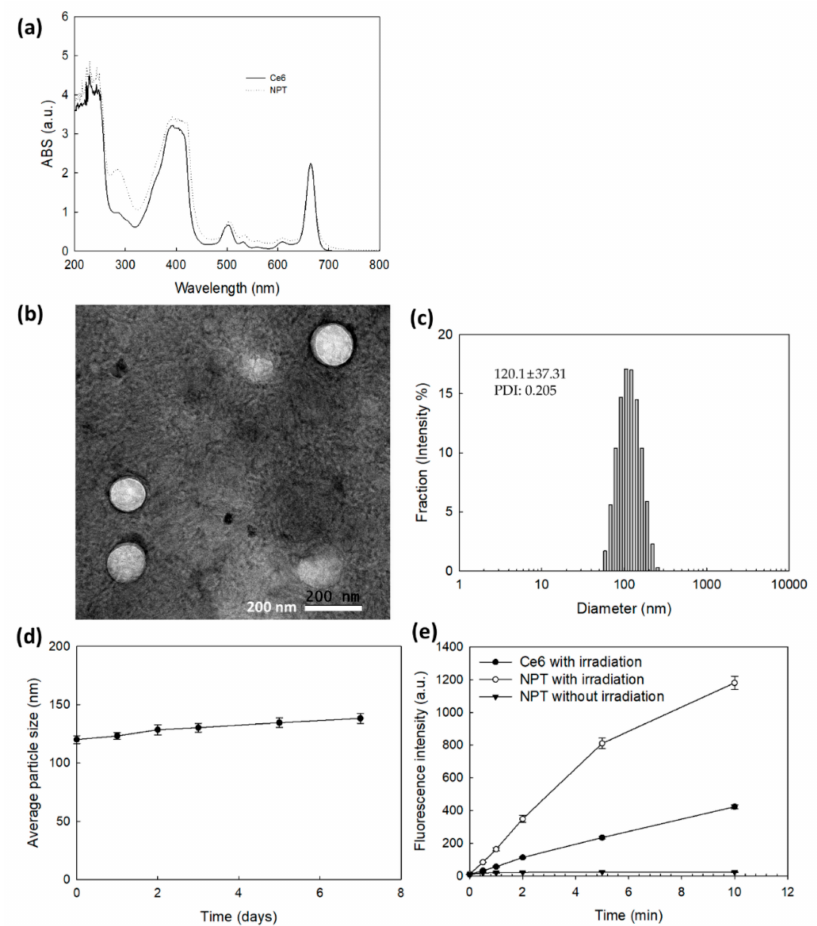
Figure 2. ( a ) UV-VIS absorption of Ce6 or FAPEGtaCe6 nanophotosensitizers in DMSO (0.1 mg/mL Ce6 equivalent). ( b ) TEM image and ( c ) particle size distribution of FAPEGtaCe6 nanophotosensi- tizers. ( d ) Stability of FAPEGtaCe6 nanophotosensitizers. For the stability test, aqueous nanophoto- sensitizer solution (1 mg FAPEGtaCe6 nanophotosensitizers/mL deionized water) was left at room temperature (20 ◦ C). ( e ) Singlet oxygen generation from Ce6 alone or FAPEGtaCe6 nanophotosensi- tizers under light irradiation at 664 nm ( n =